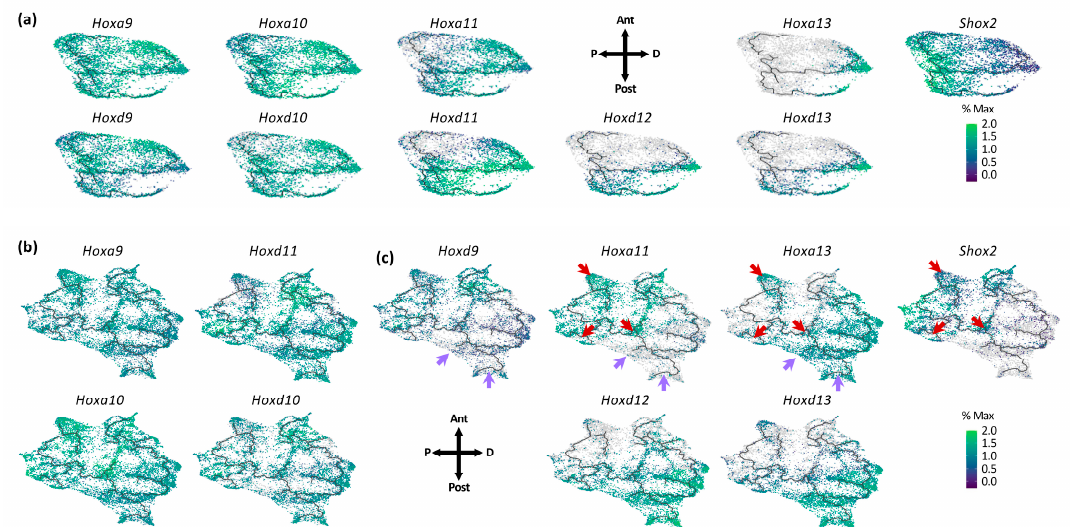
Figure 3. Distribution of Hox -expressing cells along the transcriptional trajectories during limb bud development. ( a ) UMAP visualization of the mesenchymal cells expressing the most 5’ Hoxa and Hoxd genes ( Hoxa9 , Hoxd9 , Hoxa10 , Hoxd10 , Hoxa11 , Hoxd11 , Hoxd12 , Hoxa13 and Hoxd13 ) as well as the cells expressing Shox2 at E10.5. Color scale indicated the scaled expression to percent of the maximum expression of all genes at E10.5. Orientation of the UMAP representation is indicated by the cross arrow schematic. ( b , c ) UMAP visualization of E11.5 and E12.5 mesenchymal cells expressing Hoxa9 , Hoxa10 , Hoxd10 and Hoxd11 in the all mesenchyme ( b ) and expressing Hoxd9 , Hoxa11 , Hoxd12 , Hoxa13, Hoxd13 and Shox2 in restricted areas of the mesenchyme ( c ). Red arrows indicate co-expression areas of Hoxa11 , Hoxa13 and Shox2 , and light purple arrows show the areas in which Hoxd9 and Hoxa11 are not expressed but Hoxa13 is expressed ( c ). Color scale indicated the scaled expression to percent of the maximum expression of all genes at E11.5 and E12.5. Orientation of the UMAP representation is indicated by the cross arrow schematic. Ant: anterior, Post: posterior, P: proximal, and D: